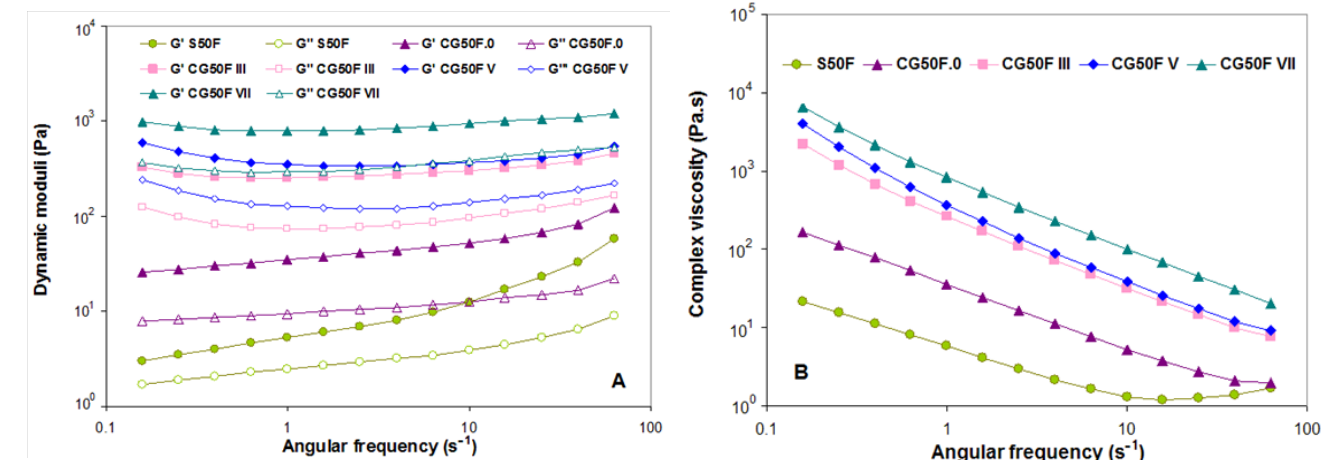
Figure 9. Effect of the lyophilization and cryogenic cycles number (III, V and VII) on the variation of ( A ) storage modulus (G′) (solid symbols) and loss modulus (G″) (open symbols) and ( B ) complex dynamic viscosity (|η*|) function of angular oscillation frequency at 25 °C for XG - based composite hydrogels obtained with a weight ratio between XG and PVA of 1:1, and Feteasca Neagra polyphenolic extracts.